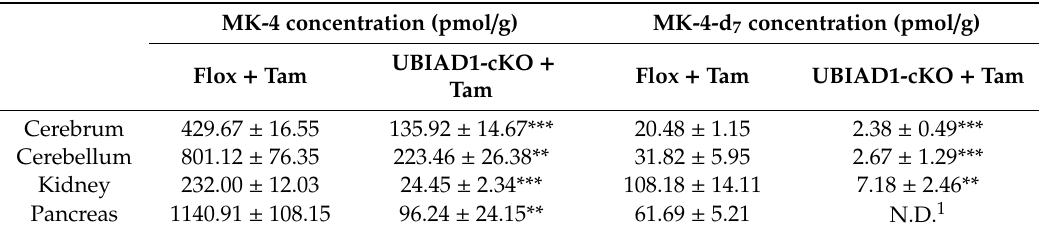
Table 2. Menaquinone-4 (MK-4) and deuterium-labeled MK-4 (MK-4-d 7 ) concentrations in the Flox and UBIAD1-cKO mice at 40 days after administration of